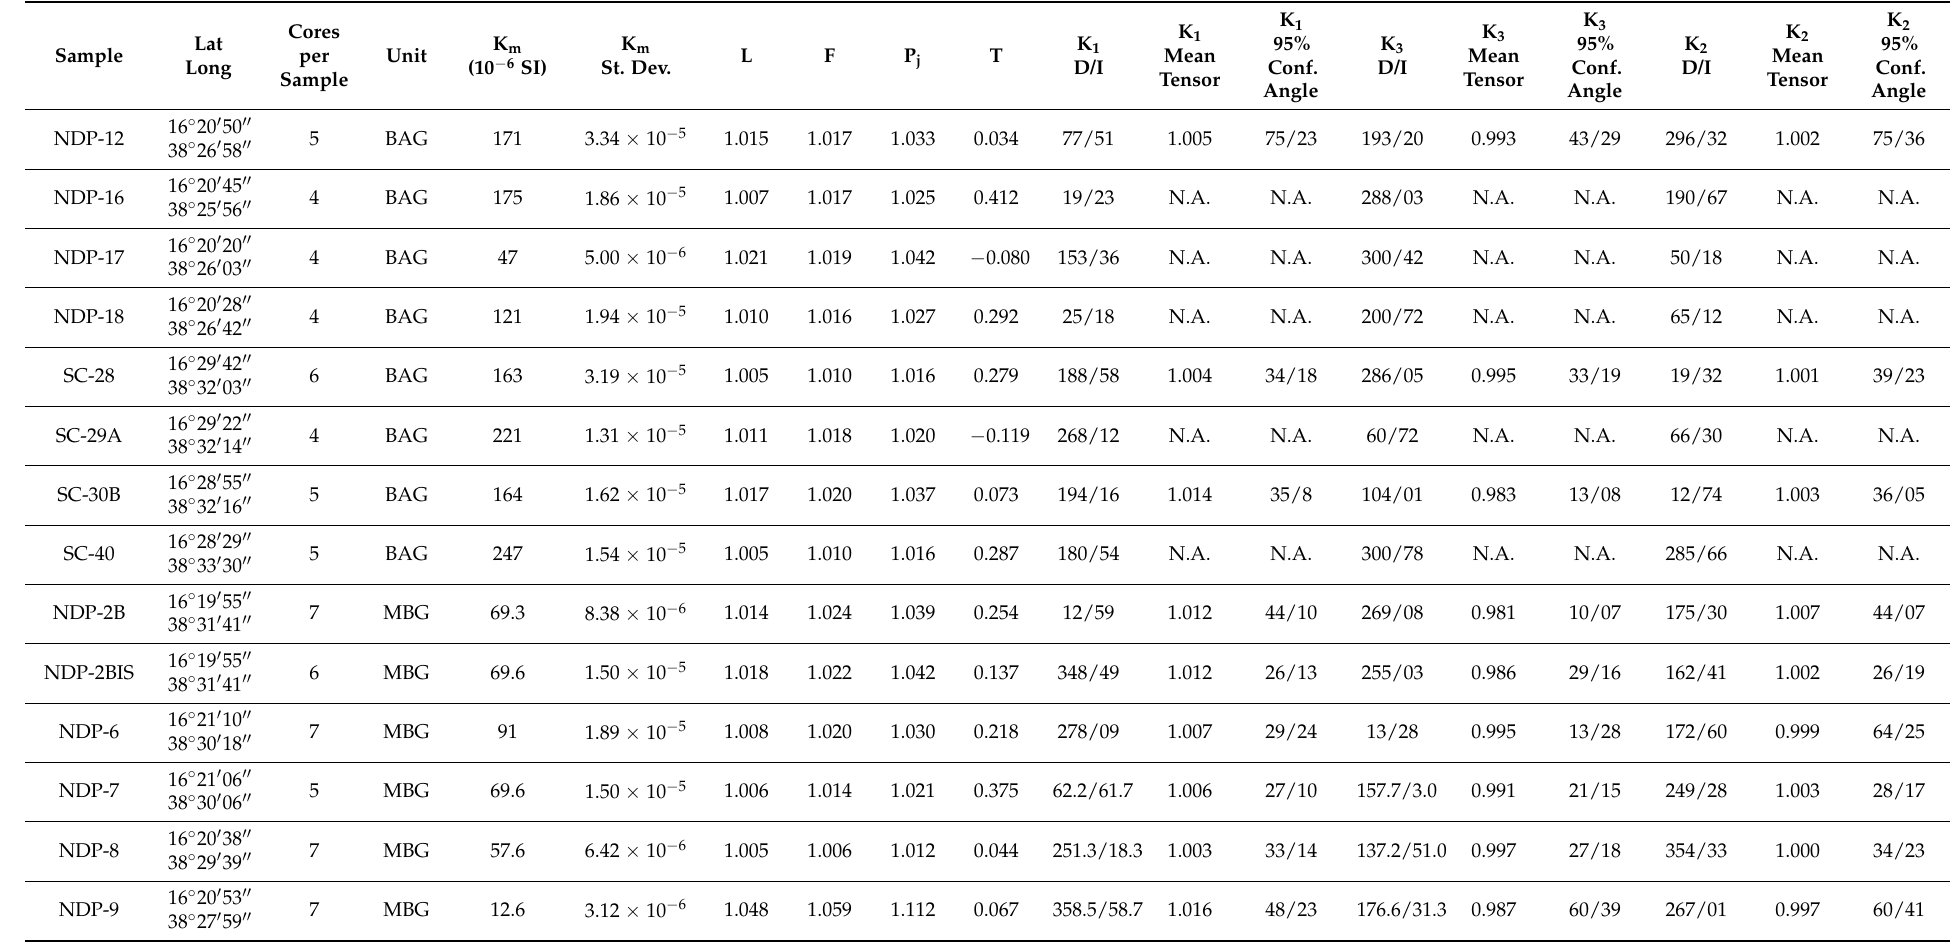
Table 1. AMS data of the Serre Batholith rocks investigated in this study. K m , L, F, P j and T are the average susceptibility, the magnetic lineation, the magnetic foliation, the magnetic anisotropy and the shape parameter, respectively. K 1 , K 2 and K 3 are the three main axes of the magnetic ellipsoid (K 1 > K 2 > K 3 ), whose declination (azimuth) (D) and inclination (plunge) (I) of the K max and K min axes are